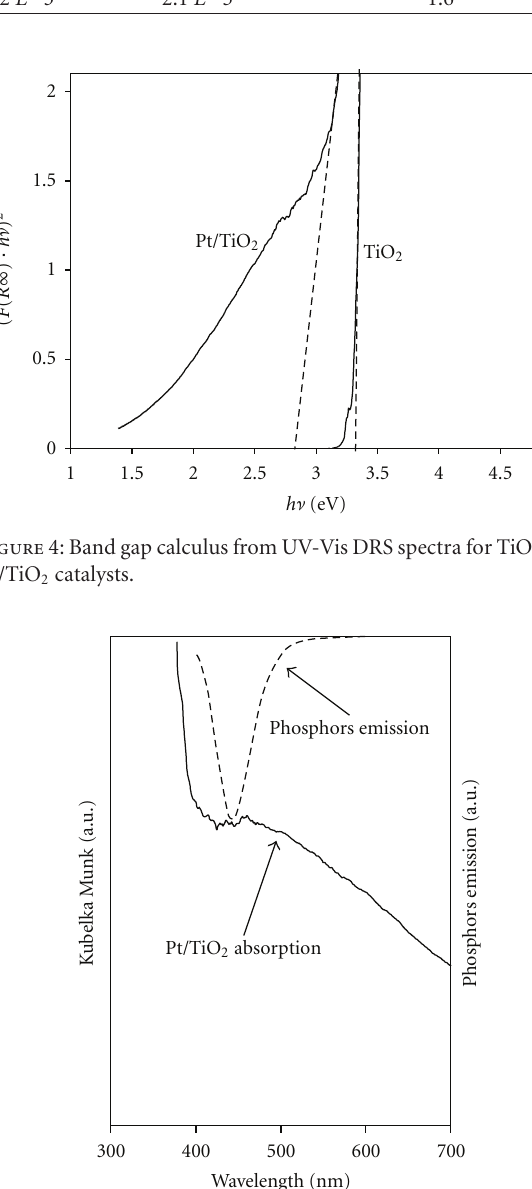
Figure 5: Comparison between Pt/TiO 2 absorption and phosphors